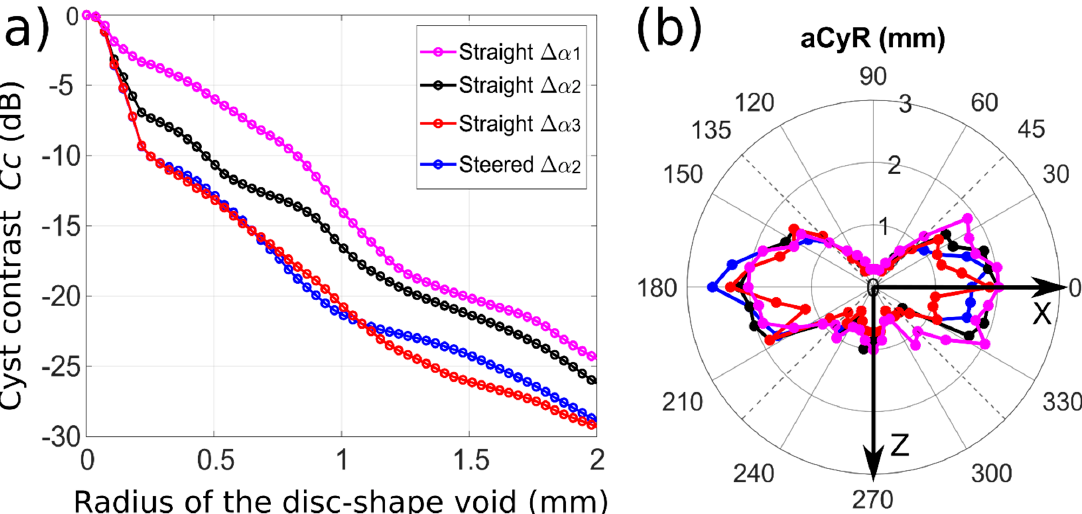
Figure 8. ( a ) Cyst contrast in dB, Cc dB , computed for line spread function (LSF) of Thread 2 as a function of the radius of disk-shaped void considered for Equation (6). The curves correspond to the different angular sampling periods and transmit modes; ( b ) polar representation of the anisotropic cystic resolution, aCyR, assessed on the LSF of Thread 2 for the different angular sampling periods and transmit modes. Table 3. Contrast parameters of the different acquisition modes. Translation range of L = 30 mm. The angular periods are Δ α 1 ≈ 8°, Δ α 2 ≈ 4°, and Δ α 3 ≈ 2°.